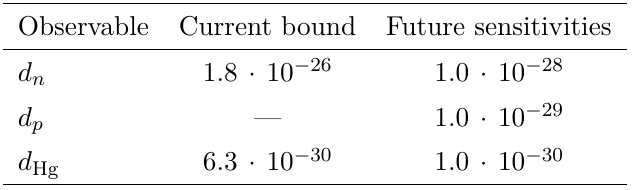
Table 1 . Current experimental limits (at 90% C.L.) on the absolute value of the electric dipole moments of the neutron d n [59], and mercury d Hg [60], and the future experimental sensitivity, including the proton d p in e cm